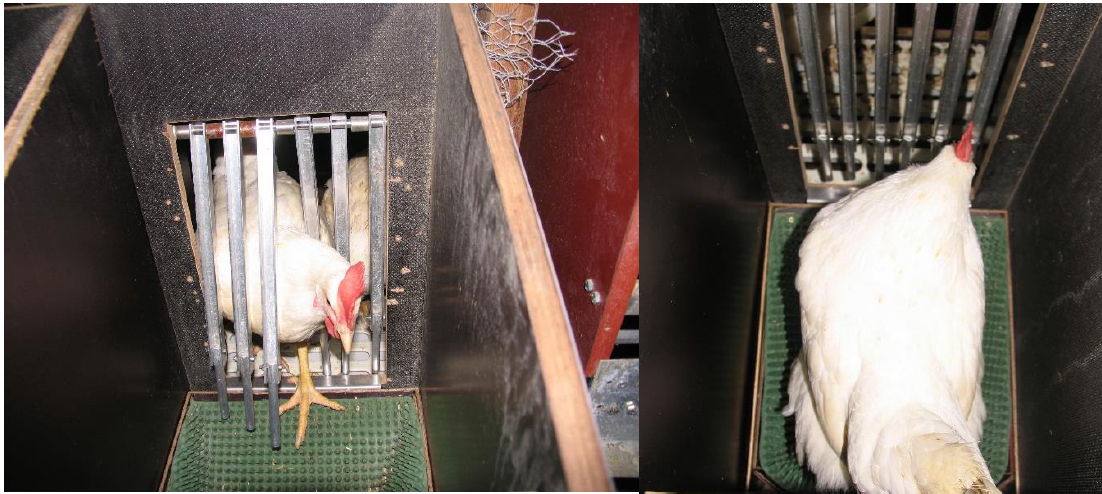
Figure 4. View of a hen entering the funnel nestbox ( left ) and positioning herself to lay an egg ( right